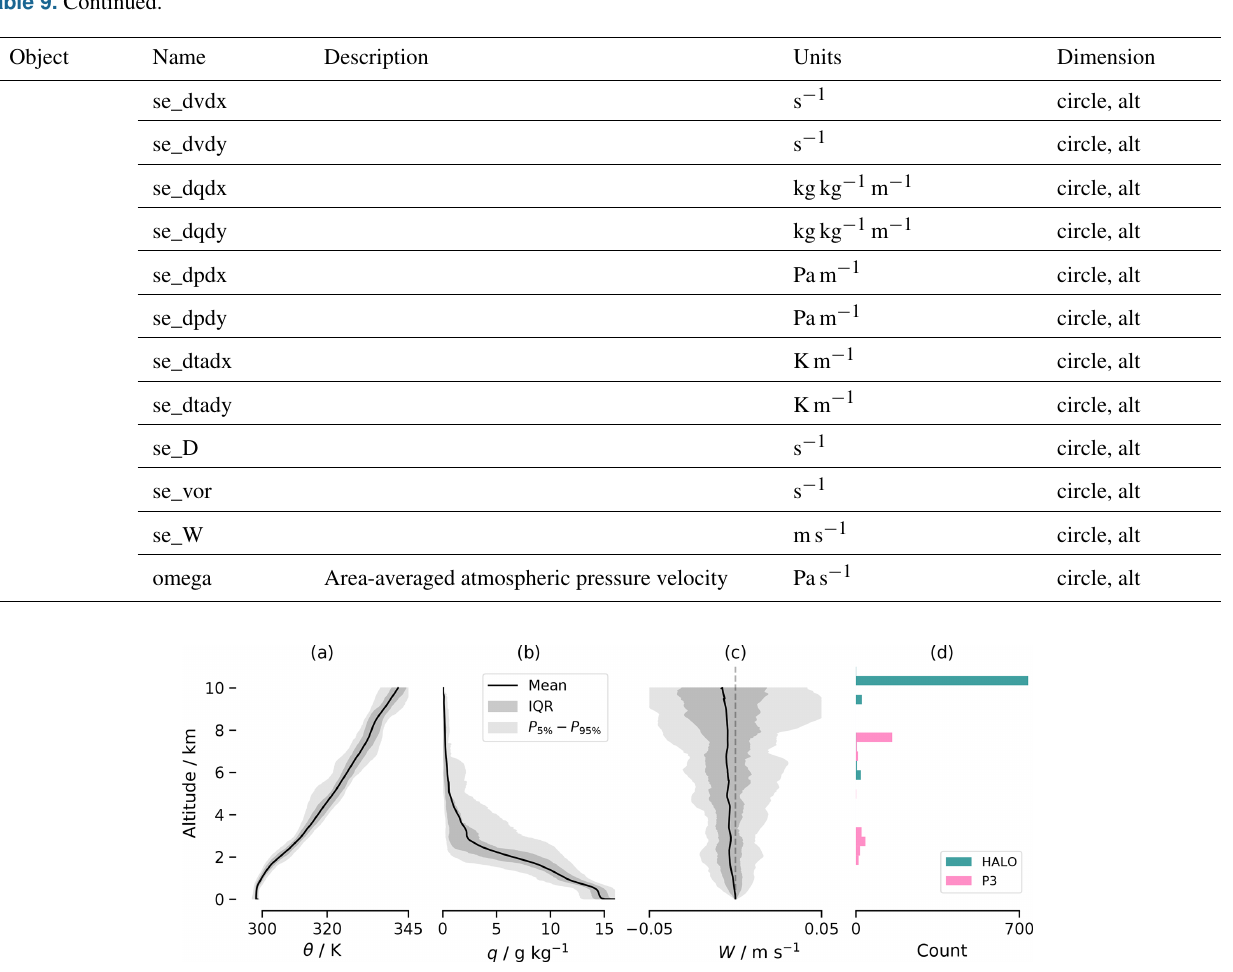
Figure 6. Vertical profiles of mean potential temperature (a) and specific humidity (b) from measurements of HALO and P3 sondes. Panel (c) shows the vertical profile of mean vertical velocity from estimates of HALO’s EUREC 4 A-circle measurements. Darkly and lightly shaded regions in (a) – (c) show inter-quartile range (IQR) and 5th–95th percentile range, respectively. Panel (d) shows the histogram for the flight altitude of dropsondes launched from both